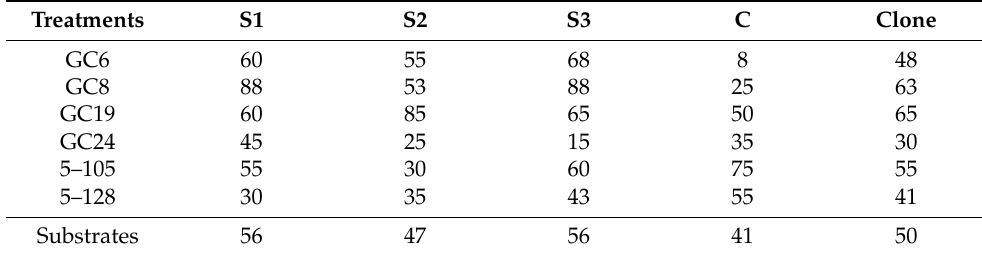
Table 4. Survival Percentages